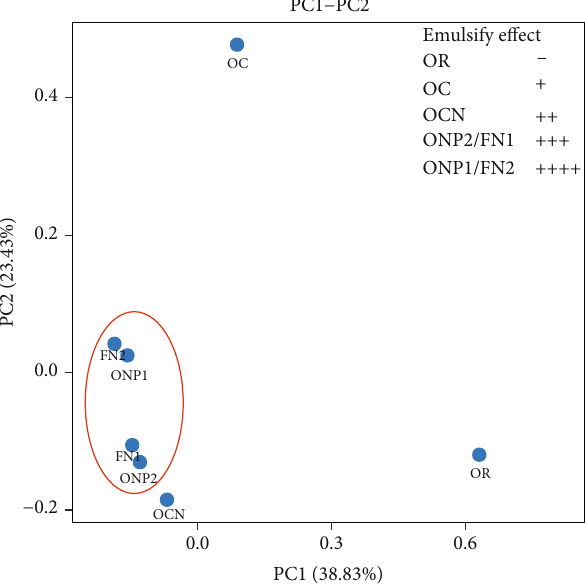
Figure 5: Principal coordinates analysis (PCoA) of each sample and the emulsifying e ff ect.